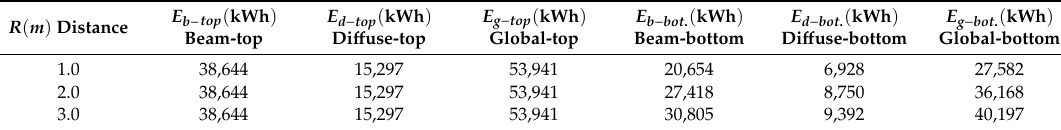
Table 1. Annual incident energies on top and bottom PV overhang collectors, H = 0.941 m , L = 30 m , ε = 70 ◦ ; see Figure